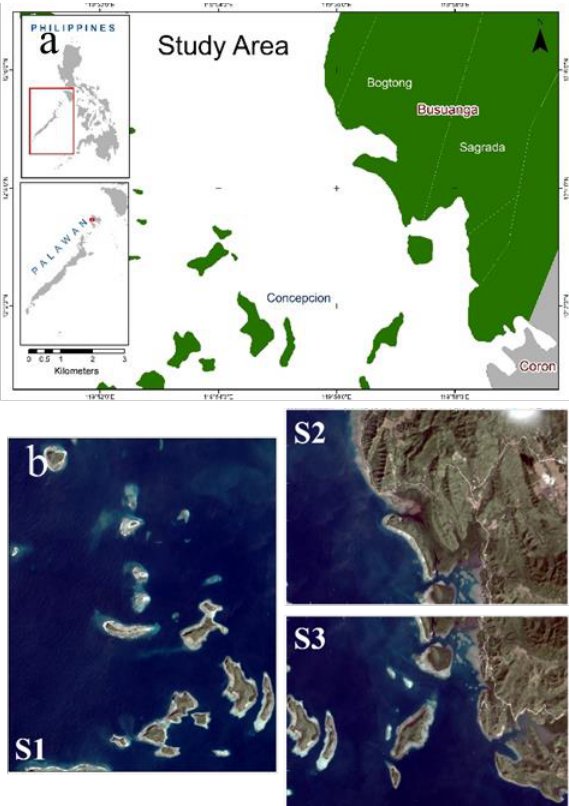
Figure 1. (a) The study area located in Busuanga, Palawan, Philippines. The site is known for marine biodiversity; and (b) The PlanetScope image utilized for the site. The site was divided into three sections labelled S1, S2, S3. Each section has a small overlap among other sections Each map was assigned to a group of volunteers in the participatory mapping